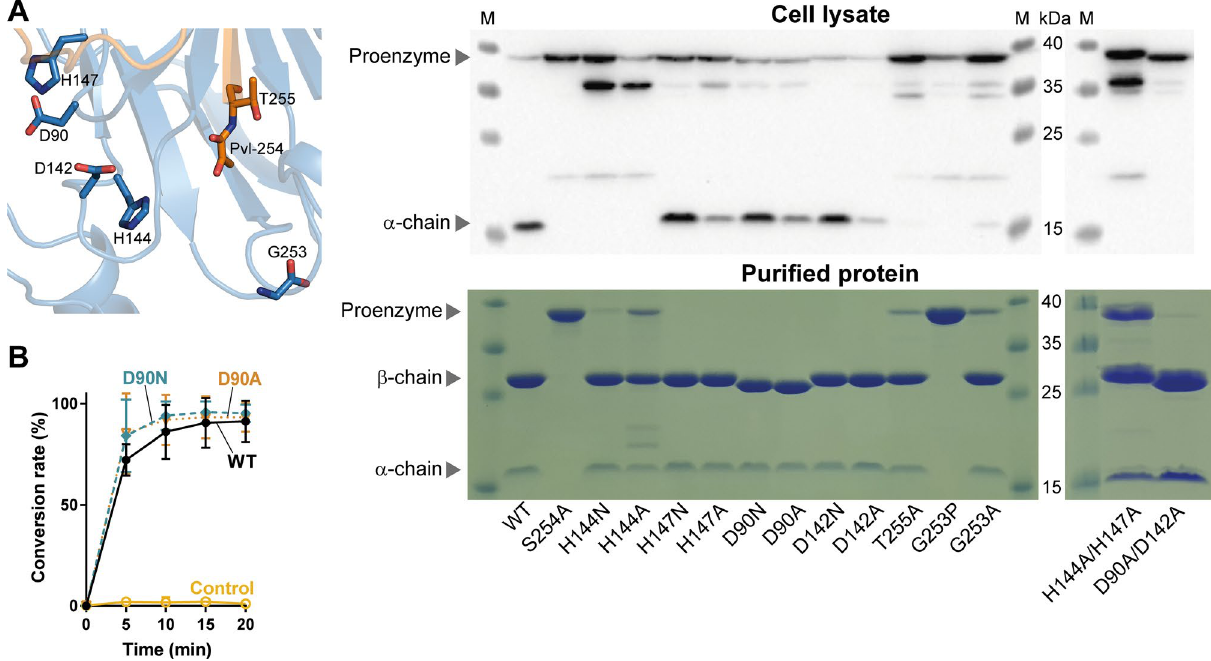
Figure 6. Key residues required for auto-cleavage of proenzyme. ( A ) Putative active site for auto-cleavage is shown where amino acid residues selected for mutagenesis are highlighted as sticks (Left). Wild-type and site- specific mutant proteins are visualized by immunoblot from cell lysates after 4 h induction (Top Right), and the purified recombinant proteins are analyzed by Coomassie staining on 12% SDS-PAGE gel (Bottom Right). Proenzyme (theoretical molecular weight, 36.9 kDa), processed β-chain (28.6 kDa), and α-chain (8.3 kDa). Lane M ladder marker. ( B ) LC–MS analysis of PS decarboxylation activity of Asp-90 mutants. Mean and standard deviation are plotted. Experiments were performed in